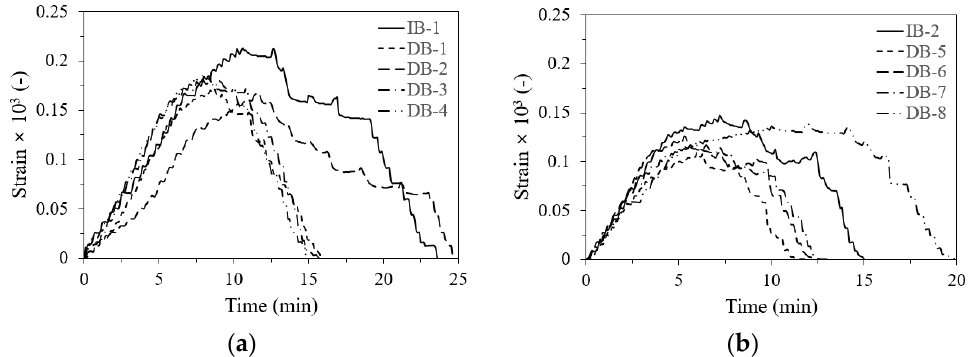
Figure 16. Strain histories of the extension structures (SG7): ( a ) Group A; ( b ) Group B.